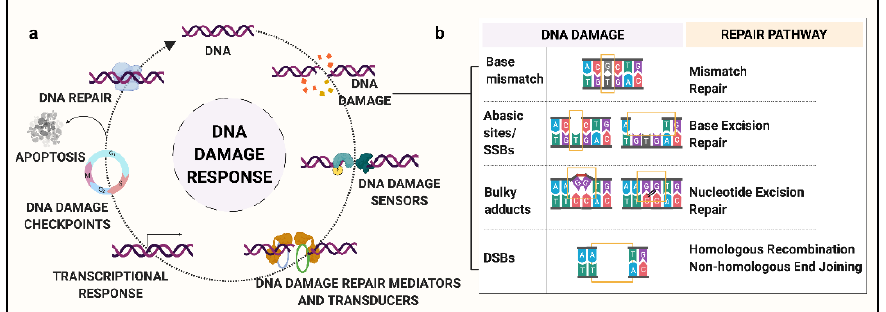
Figure 1. Pictorial representation of ( a ) DNA damage response and ( b ) types of DNA damage and their repair pathways. ( a ) DNA damage response includes the recognition of DNA damage by DNA damage sensors, recruitment of DNA damage repair mediators and transducers, modulation of transcriptional response, activation of DNA damage checkpoint kinases, and lastly, restoration of DNA duplex or apoptosis signaling if the damage is unrepairable. ( b ) Types of DNA damage include base mismatches repaired via mismatch repair pathway, abasic site or SSBs repaired via base excision repair, bulky adducts repaired via nucleotide excision repair, and DSBs repaired via homologous recombination or non-homologous end joining. DNA, deoxyribonucleic acid; SSBs, single-stranded DNA breaks; DSBs, double-stranded DNA breaks. Created with BioRender.com. DNA damage includes single-stranded DNA breaks (SSBs), abasic sites, modified bases, double- stranded DNA breaks (DSBs), and inter- and intra-strand crosslinks (Figure 1b) [26]. Abasic sites, SSBs, and DSBs fall into the category of DNA backbone damage, which is the most frequent type of DNA damage [26]. Abasic or AP sites (apurinic/apyrimidinic site) are characterized by the absence